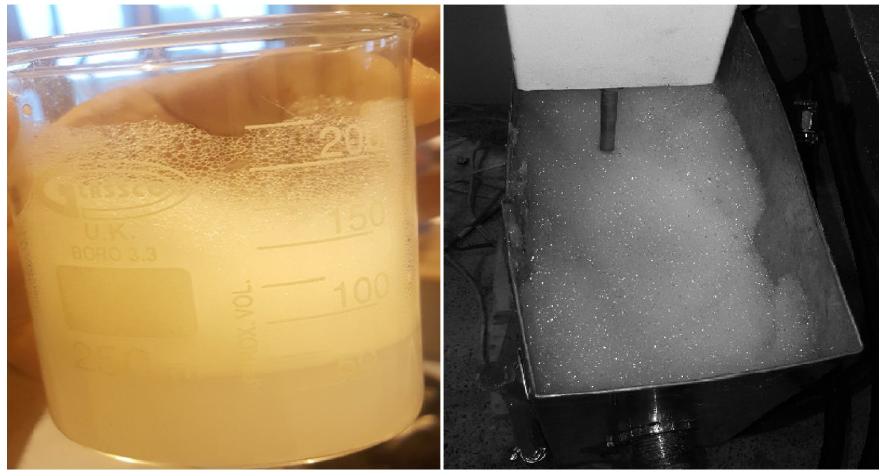
Figure 5. Formation of foam when using sodium dodecyl sulfate as a